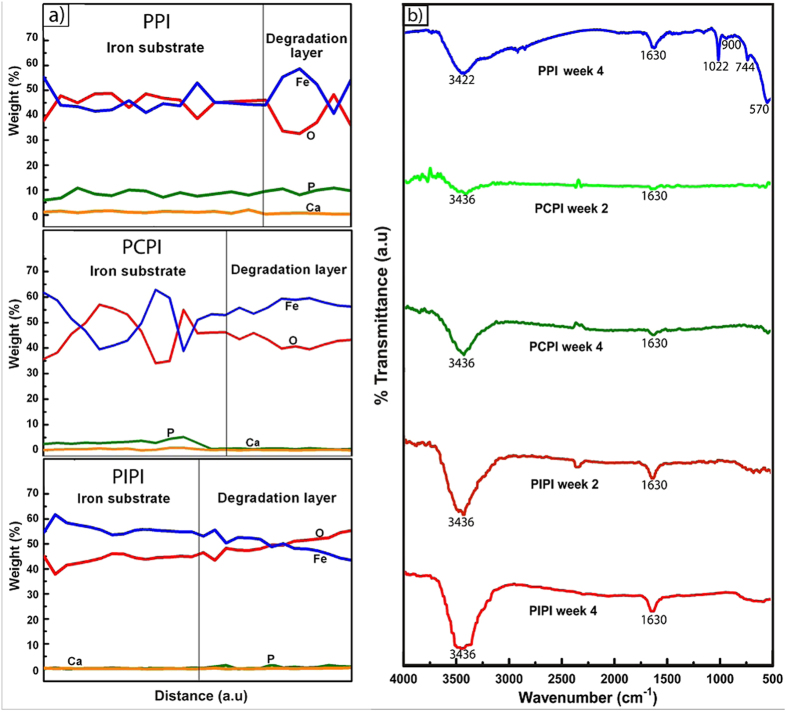
Assessment on degradation layer:(a) EDS elemental profiles across the iron substrate and degradation layer, (b) IR spectra of PPI, PCPI and PIPI degradation products after 2 and 4 weeks of degradation.